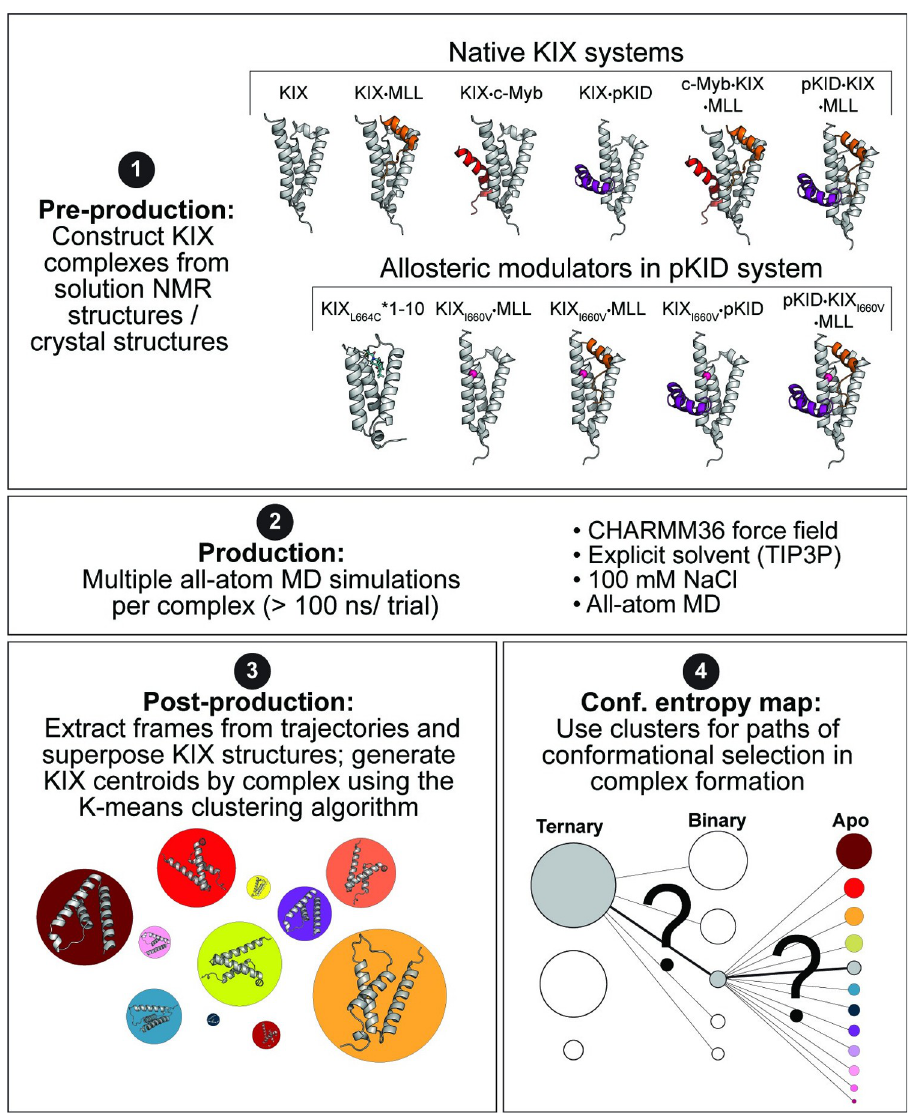
Fig 2. Molecular dynamics methods for dissecting KIX conformational entropy. [ Panel 1 ] Six native systems are constructed using the ternary solution NMR structures for c-Myb•KIX•MLL (used to construct apo KIX, KIX•MLL, and KIX•c-Myb; PDB 2agh) and pKID•KIX•MLL (used to construct KIX•pKID; PDB 2lxt). The KIX I660V mutant systems were created using the coordinates for the WT protein and mutating the residue to valine in CHARMM. The KIX L664C � 1–10 structure used coordinates from the crystal structure of KIX L664C Tethered to molecule 1–10 through a disulfide bond (PDB 4i9o). [ Panel 2 ] All atom molecular dynamics simulations were performed in replicates for each of the system in panel 1. Simulations contained 100 mM NaCl and were performed using CHARMM. [ Panel 3 ] Structural frames of KIX from simulations were superposed and subjected to K-means clustering using 2.5 Å RMSD cutting on C α atoms. [ Panel 3 ] The distribution of KIX clusters was projected in two dimensions where each circle represents a given KIX cluster (i.e. conformational microstate), with size corresponding to occupancy (i.e. number of frames in given cluster). [ Panel 4 ] In answering how the distribution of KIX states shifts with binding partners, ternary micro-states were iteratively compared binary micro-states using K-means clustering. This was repeated from binary to apo micro-states, which allowed for conformational selection maps to be